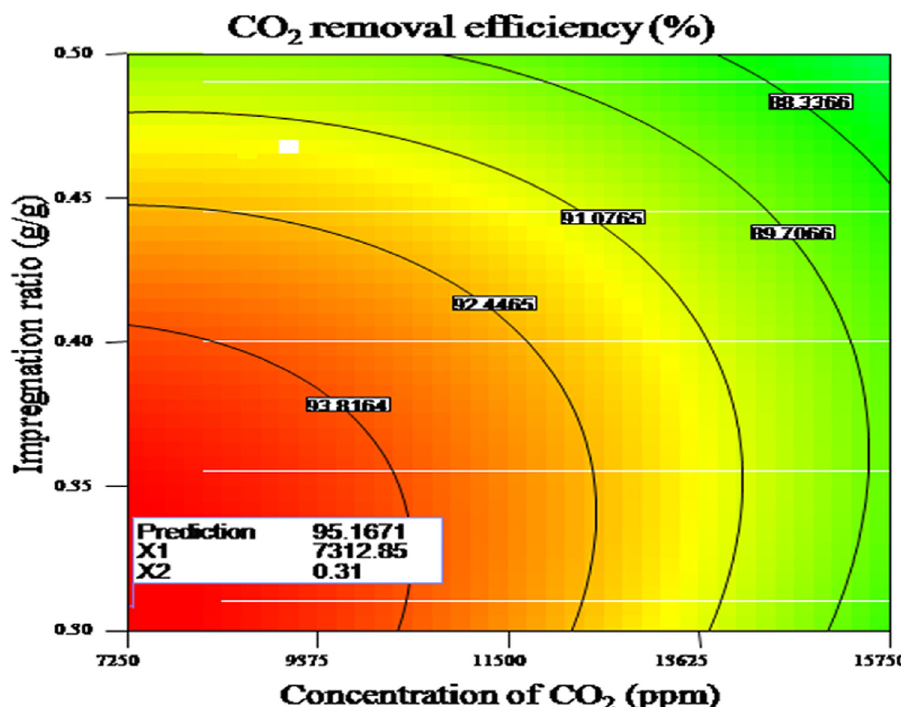
Fig. 10 Optimum region on the inlet concentration of CO 2 and impregnation ratio for the CO 2 removal efficiency (%)